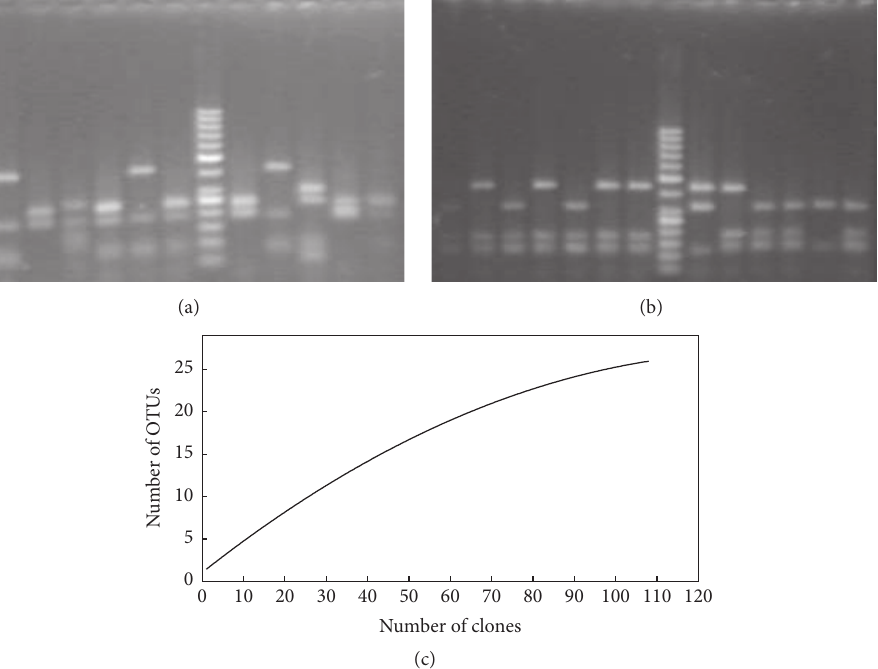
Figure 1: RFLP analysis of the retrieved clones. (a) Agarose gel electrophoresis of products after restriction with Msp I; 1–6, 8–12: restriction patterns; 7: marker Gene Ruler 50 bp (Fermentas). (b) Agarose gel electrophoresis after restriction with Hae III of the sequences with the same Msp I restriction pattern; 1–6, 8–14: restriction patterns; 7: marker Gene Ruler 50 bp (Fermentas). Additional splitting of the group was observed. (c) Rarefaction curve for sampling of PS 16S rRNA archaeal gene library. Rarefaction curve was calculated using Analytical Rarefaction version 1.3